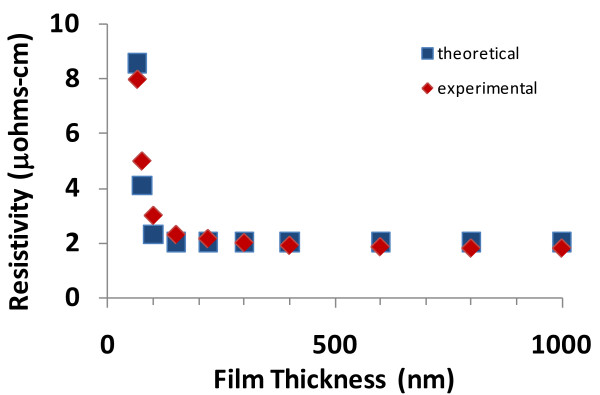
Comparison of theoretical and experimental resistivities for silver as a function of film thickness. (The experimental data is adapted from Dayal et al. [13].)